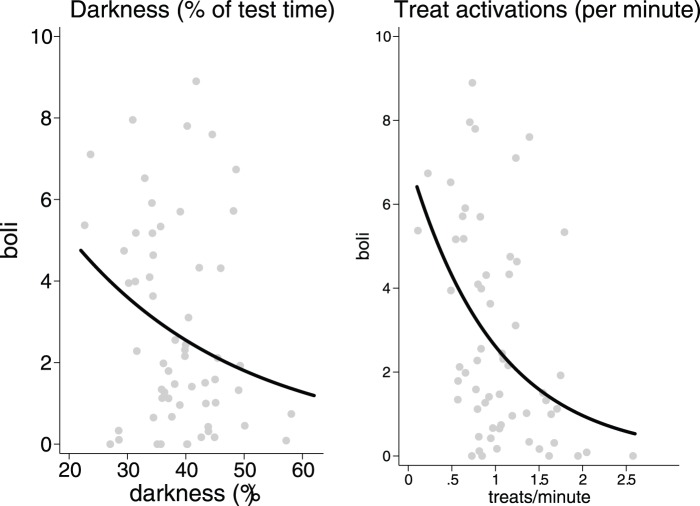
Individual differences and chronic differences in anxiety responses or welfare (black lines are Poisson regression model fit; grey dots are individual means).At the level of the individual (and not the situation), prevention success and promotion success were both significantly related to less fecal boli (P<.05 and P<.001, respectively).